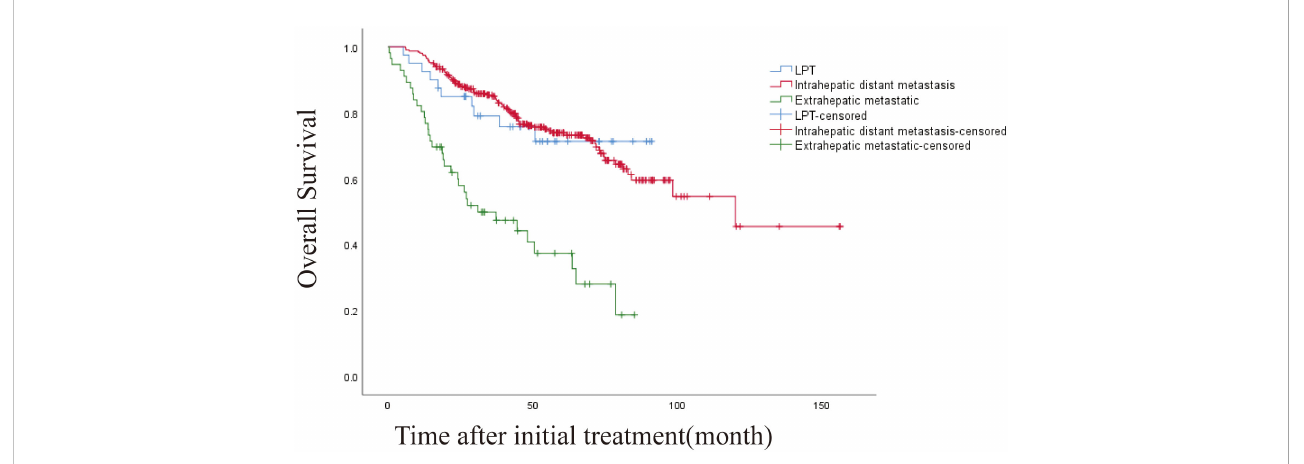
FIGURE 3 Kaplan-Meier curves of overall survival (OS) in patients with LPT, intrahepatic distant metastasis, and extrahepatic metastasis. (overall